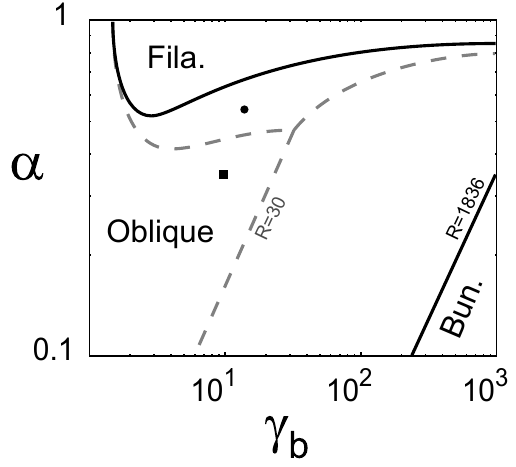
Fig. 5. Mass ratio dependant hierarchy map for the system de- scribed in Sect. 2. The system represented by a circle switches from an obliquely dominated regime to a filamentation one, when the mass ratio goes from 1836 to 30. By contrast, the system rep- resented by the square is governed by the same kind of mode for R = 30 and 1836.